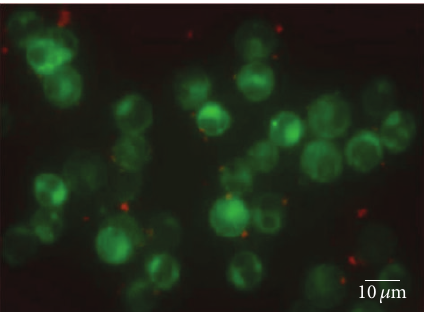
Figure 4: Mechanism of BMMC-exosome function in naive CD4 + T cells. Exosomes and T cells were stained with Dil (red-orange) and Dio (green), respectively. During the first 24 hours, exosomes were found to adhere to T cells and no endocytosis was observed. The picture was taken 12 hours after the coculture at a magnification ×